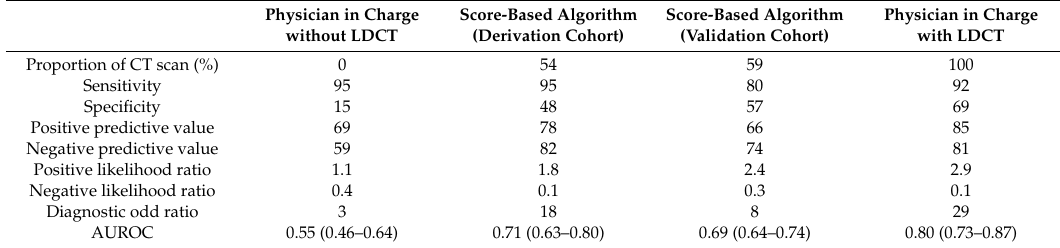
Table 4. Accuracy of physician assessment and score-based